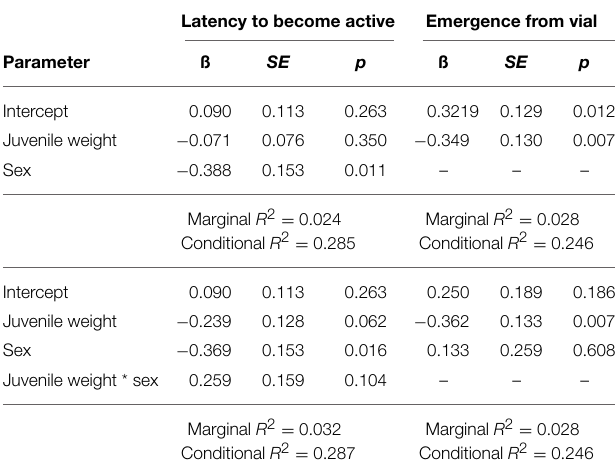
TABLE 6 | Top generalized linear mixed models predicting the (log) latency to become active within the vial and the likelihood of fully emerging from the